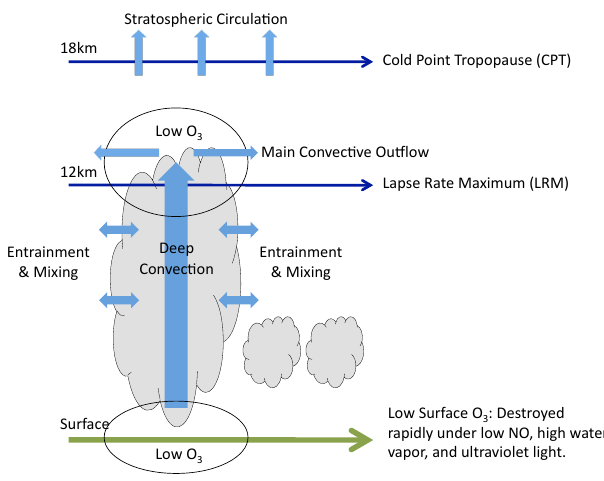
Fig. 1. A conceptual model for understanding ozone as a tracer of deep convection. Low ozone concentrations near the surface can be transported to the upper troposphere within deep convective updrafts and detrained around the level of deep convective outflow. Entrainment and mixing can dilute the updraft, distorting the convective ozone signal.